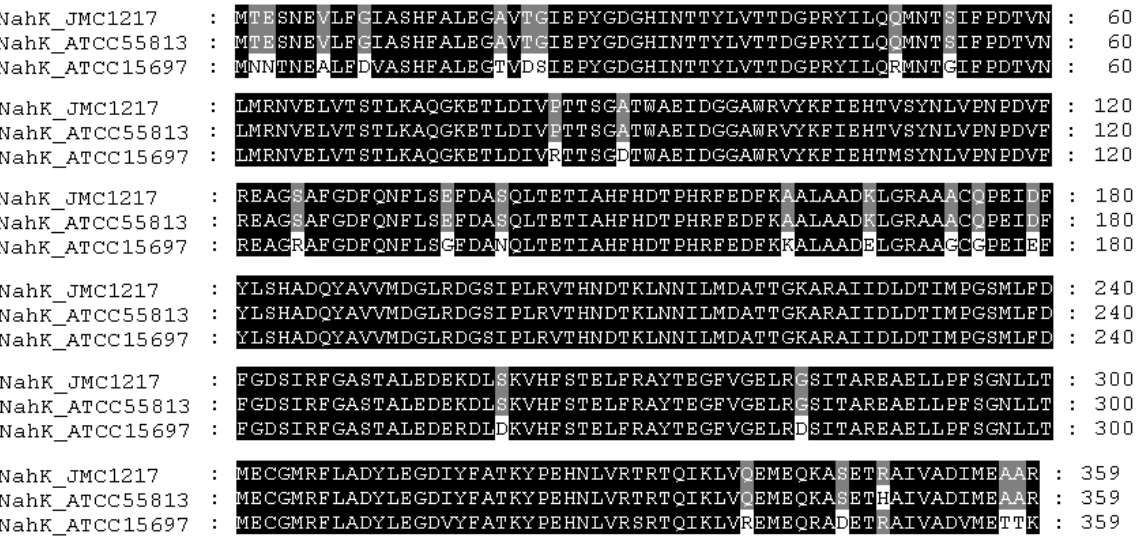
Figure 1. Sequence alignment of NahK_JCM1217 (GenBank accession no. BAF73925), NahK_ATCC55813, and